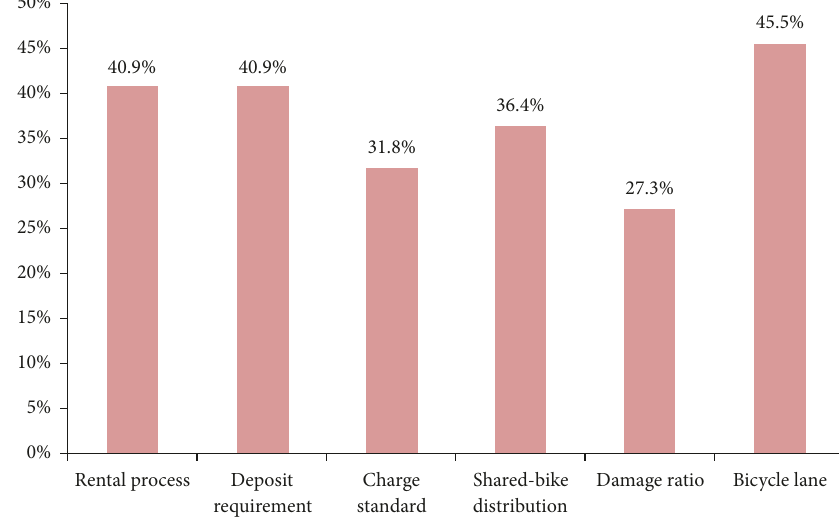
Figure 4: Expected improvements for bicycle-sharing